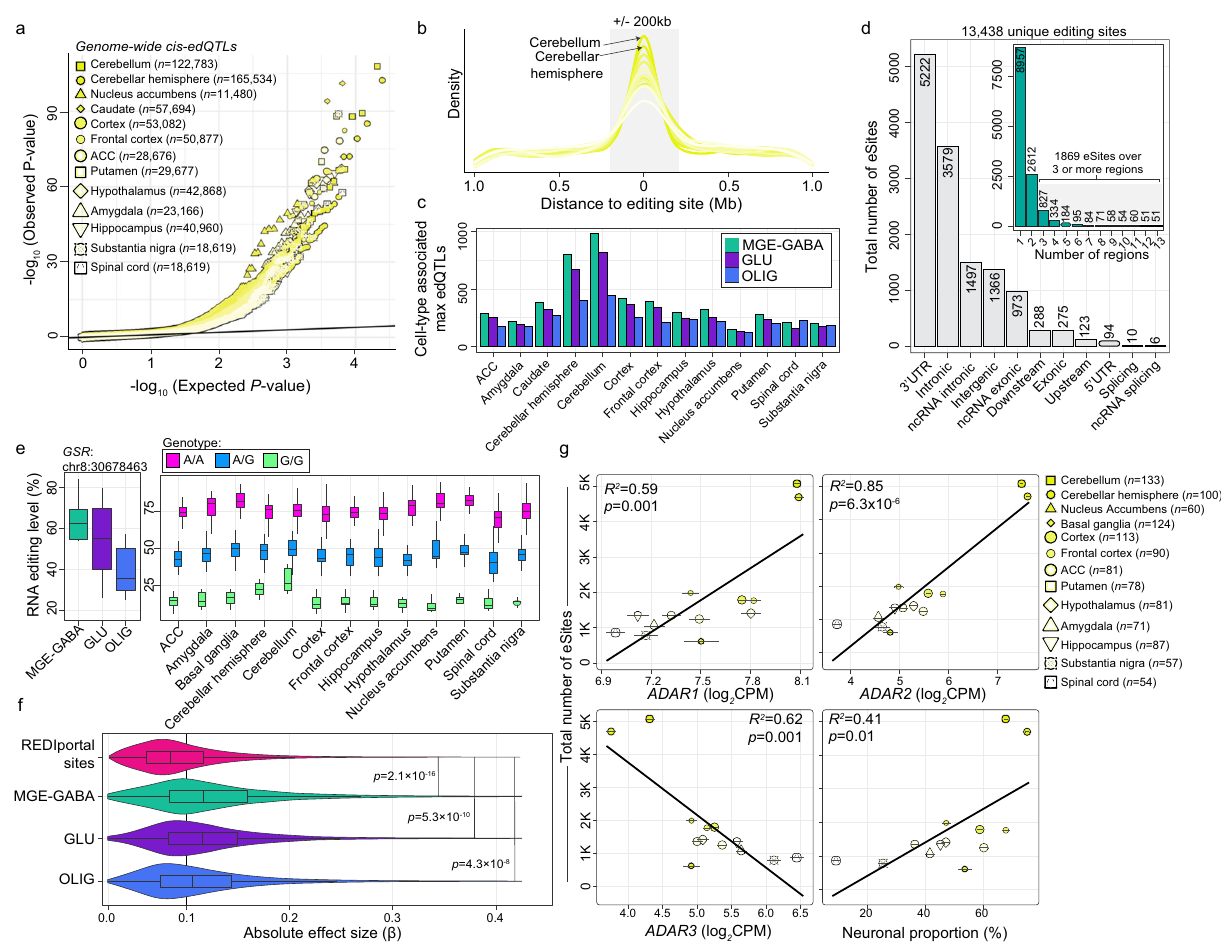
Fig. 7 Identi fi cation and annotation of edQTLs across multiple brain regions. a QQ-plot depiction of observed versus expected P values for genome-wide cis-edQTLs . b Max-edQTL SNPs are highly enriched within 200 kb of their respective editing sites. c Counts of cell type-associated max-edQTLs in each brain region. d The total number of eSites (unique editing sites with associated edQTL) are broken down by genic region. Inset plot counts the number of eSites commonly detected across more than one region. e An example of one commonly detected edQTL across all regions with neuronal cell type- enriched editing rates (left) with the consistent direction of edQTL effect across all regions (right). f The absolute effect size ( β , x-axis) is compared for edQTLs annotated as cell type-associated or edQTLs without cellular identify. All box plots show the medians (horizontal lines), upper and lower quartiles (inner box edges), and 1.5 × the interquartile range (whiskers). g Two-sided regression analysis indicates that eSite discovery is dependent upon regions expressing higher levels of ADAR1 , ADAR2 , and those with higher proportions of neurons. No adjustments were made for multiple comparisons. The total number of biological replicates for each GTEx region are provided in panel g and Supplementary Table